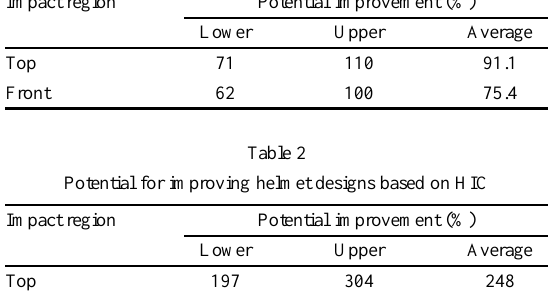
Potential for improving helmet designs based on peak head acceleration Impact region